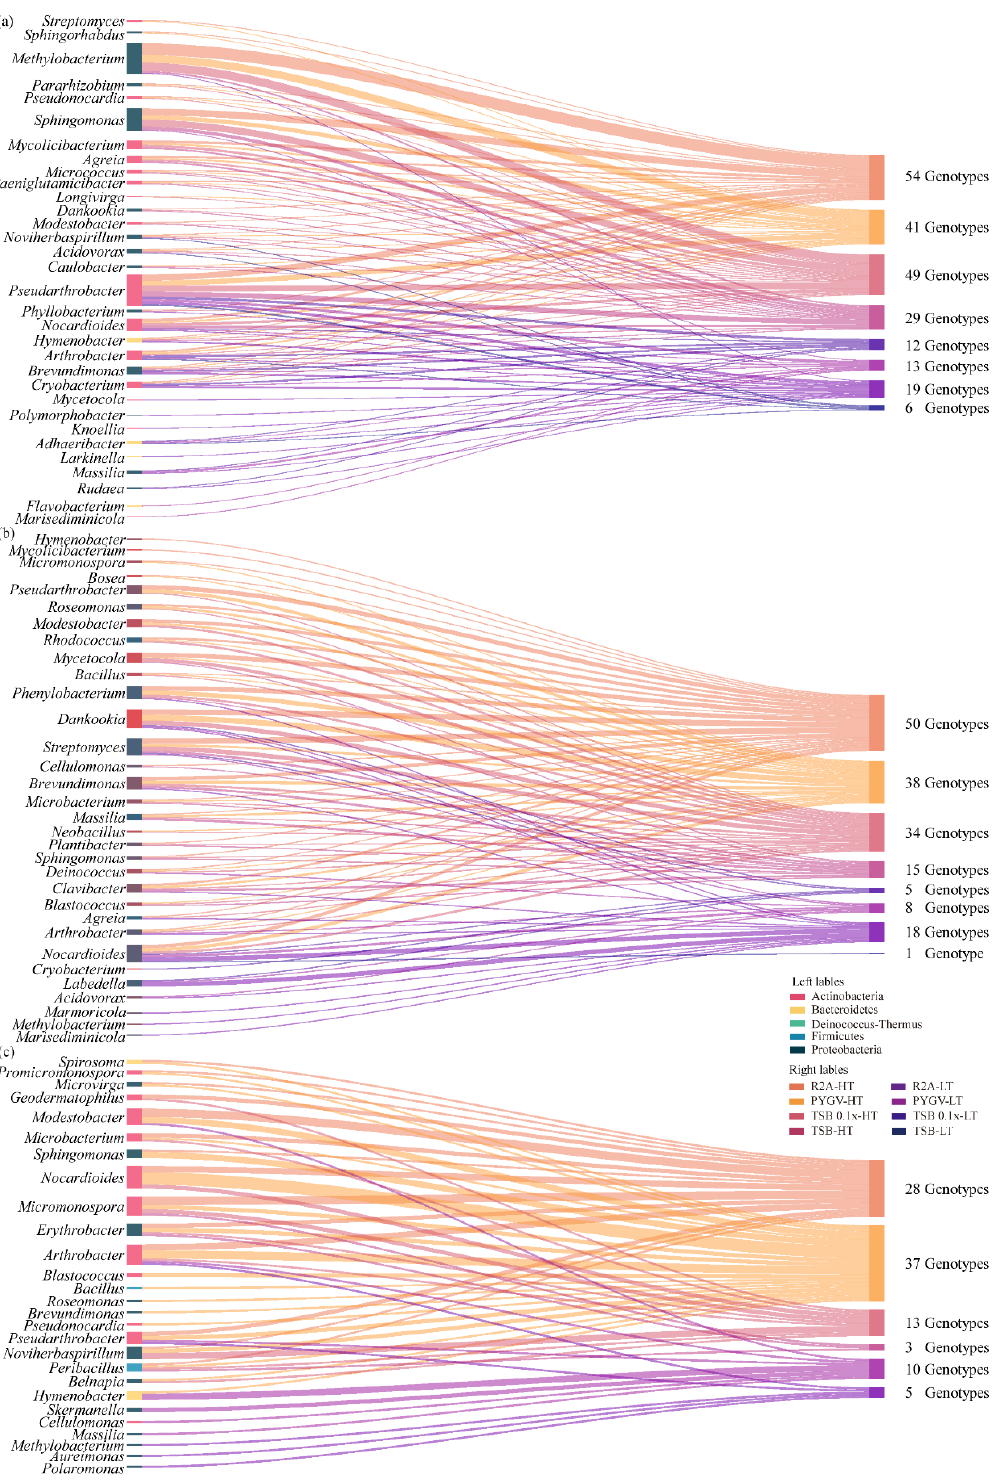
Figure 4. Distribution and diversity of bacteria cultured using different strategies, including different temperatures, media, and pre-treatments. ( a – c ) represent the genera of bacteria isolated from nor- mal culture samples (non-pretreatment), samples pre-treated with H 2 O 2 (oxidation), and samples irradiated with UV-C, respectively.